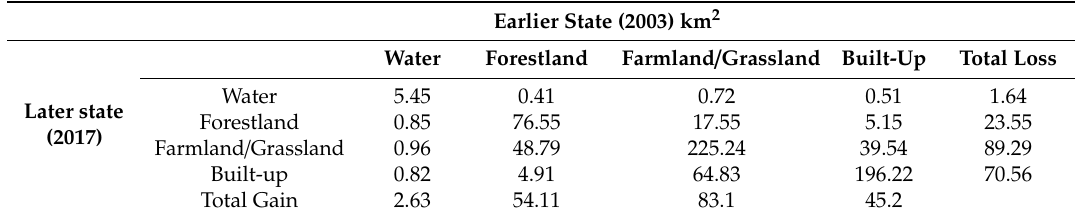
Table 7. Major LULC class changes from 2003 to 2017 from LANDSAT